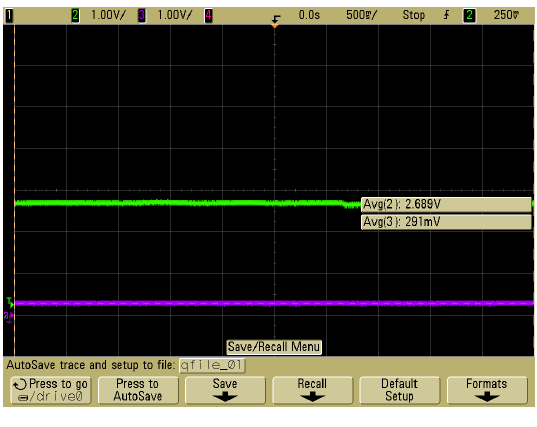
Figure 6. Response at rest.